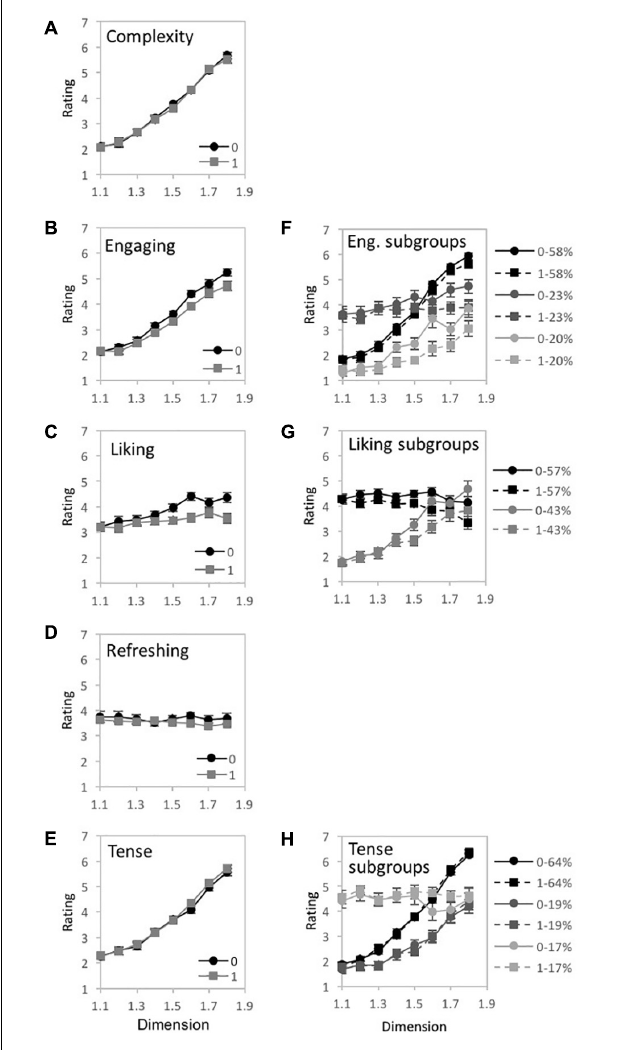
FIGURE 9 | Experiment 1B results for “global forest” fractal patterns for 5 different judgment conditions (complex, engaging, liking, refreshing, and tense). (A–E) shows plots of mean ratings as a function of fractal dimension ( D ) and 2 pattern arrangements (not randomized “0,” randomized “1”) for the different judgment conditions (error bars represent standard error). (F–H) shows plots of mean ratings as a function of fractal dimension ( D ) and 2 pattern arrangements (not randomized “0,” randomized “1”) for each subpopulation identified with cluster analysis (error bars represent standard